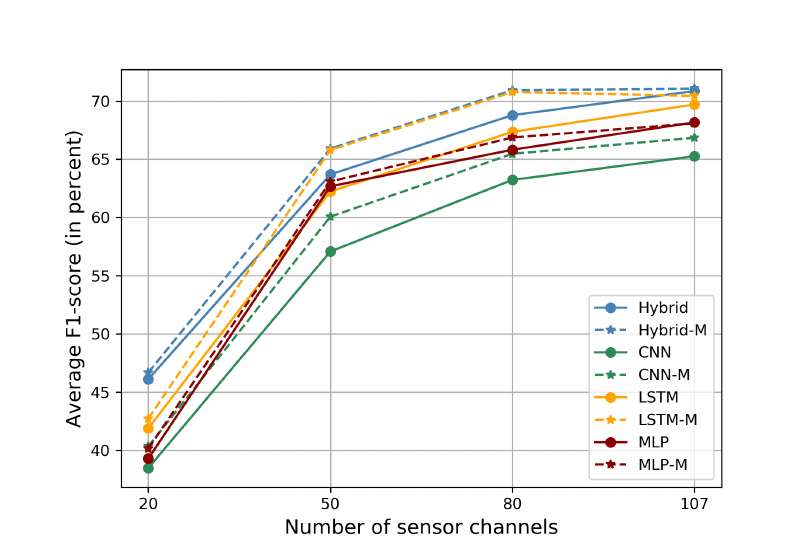
Figure 6. The average F1-score (in percent) using different numbers of sensor channels on the OPPORTUNITY dataset.